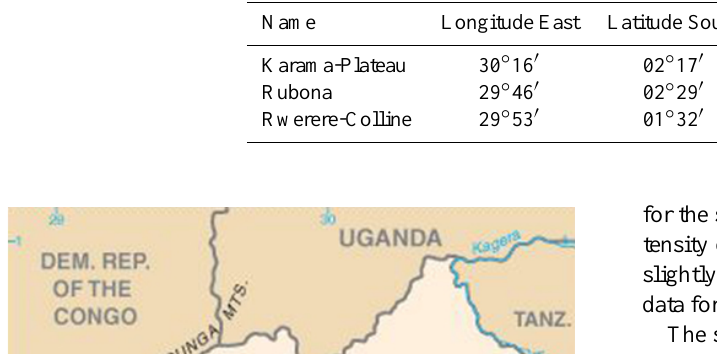
Table 1. Name, geographical co-ordinates, altitude and operating service of the stations Karama-Plateau, Rubona and Rwerere-Colline in Rwanda.